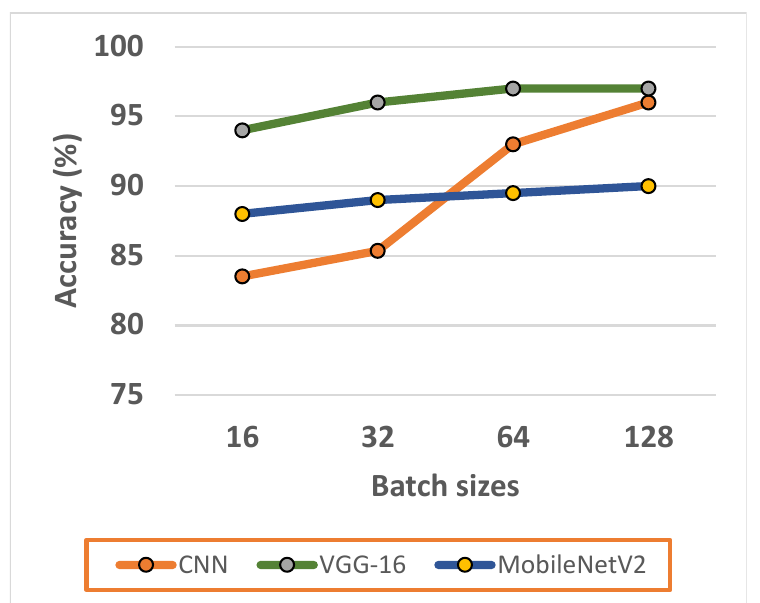
Figure 16. Testing accuracies of the pest pattern with variant batch